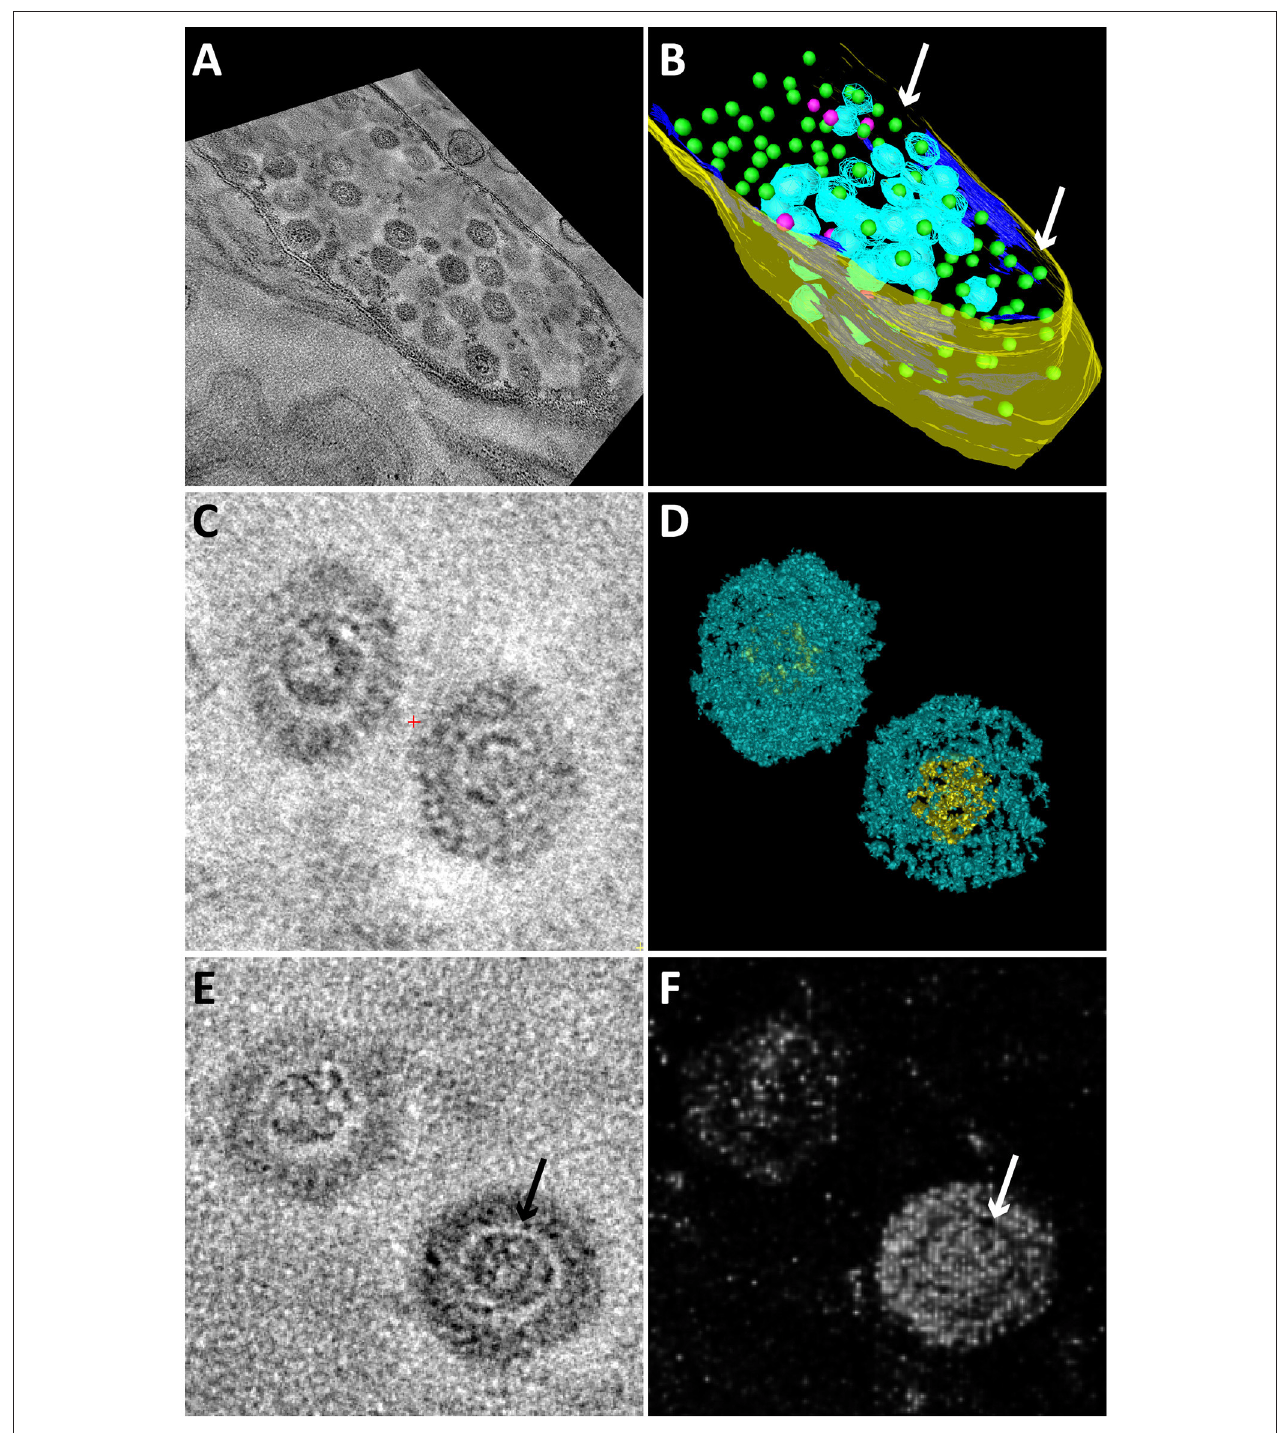
FIGURE 4 | Snapshots of electron tomograms and models of free and intracellular bacteriophages infecting Methylomirabilis cells. Tomogram (A) and model (B) of an infected Methylomirabilis cell. Most bacteriophages have the capsid (blue) assembled around the electron dense core (green). Some bacteriophages are still in the process of assembly and only consist of the electron dense core (pink). The cell is swollen and the cytoplasmic membrane (dark blue) is broken at many places (arrows). The cell wall (yellow) is still intact. All green electron dense cores were surrounded by a capsid, but not all capsids were modeled for reasons of clarity. Tomogram (C) and isosurface density model (D) of two free bacteriophages showing the icosahedral capsid (blue) and electron dense core (yellow). Tomogram (E) and Chimera model (F) showing two free bacteriophages. The electron dense core is enclosed by a putative membrane (arrows).